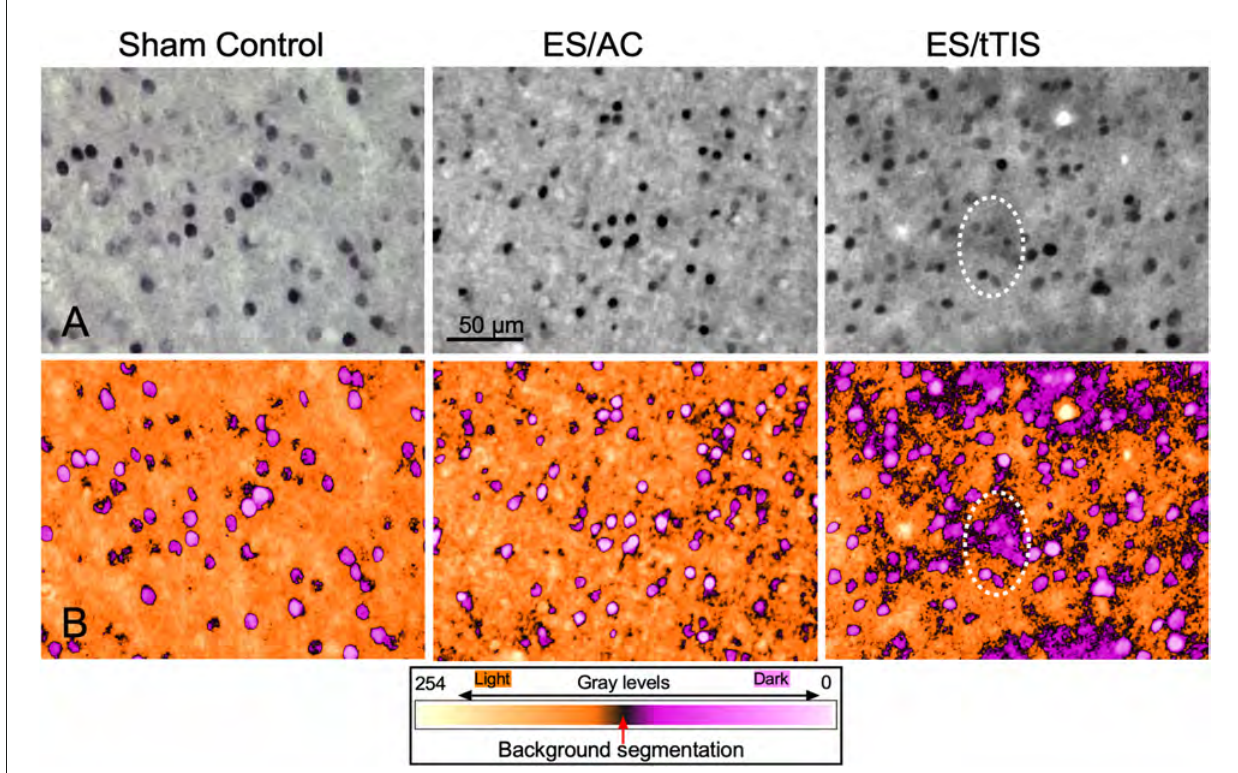
FIGURE1 c-Fos immunoreactivity analysis using the independent component analysis (ICA) color space method for pattern recognition. (A) c-Fos immunostaining in the three experimental groups. A mild interstitial dense reaction product around the cell nuclei (dotted line) can be observed. (B) Corresponding images resulting after optical density-to-color processing applying the ICA3 plugin from ImageJ program. The encircled area (dotted line) shows that nuclei in white can be easily distinguished from the cytoplasm in the magenta. All images were taken under the same conditions of microscopic illumination and analyzed without any digital manipulation of brightness, contrast, or color. The inset shows the optical density-to-color calibration